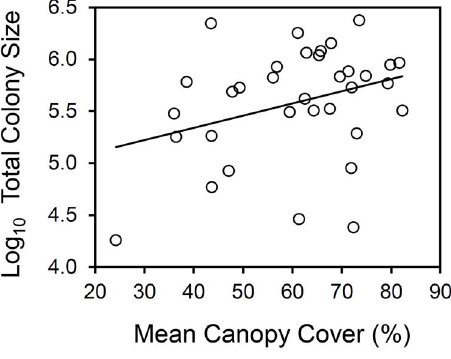
Fig. 2. The trend between total colony size and mean canopy cover of 34 colonies. Linear regression, solid line: y 5 0.0117 x + 4.8727, F ratio 5 3.67, P 5 0.06, r 2 5